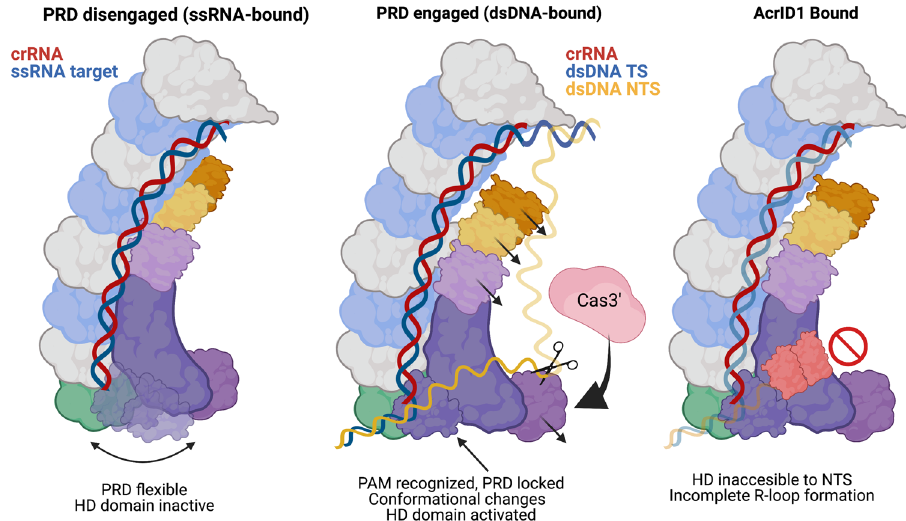
Fig. 5 Model for type I-D Cascade activity. Single-stranded target-bound Cascade has a fl exible PRD (PRD disengaged). Upon binding of a dsDNA target, the PRD engages, recognizing the PAM and locking it into place. This allows I-D Cascade to undergo conformational rearrangements in Cas11d and Cas10d that allow for activation of the HD domain for cleavage of the NTS. The binding of AcrID1 blocks the path of the non-target strand towards the Cas10d HD site, preventing binding and R-loop formation with dsDNA targets. The nucleic acids are colored and labeled above each cartoon. Subunits are colored as in Fig.